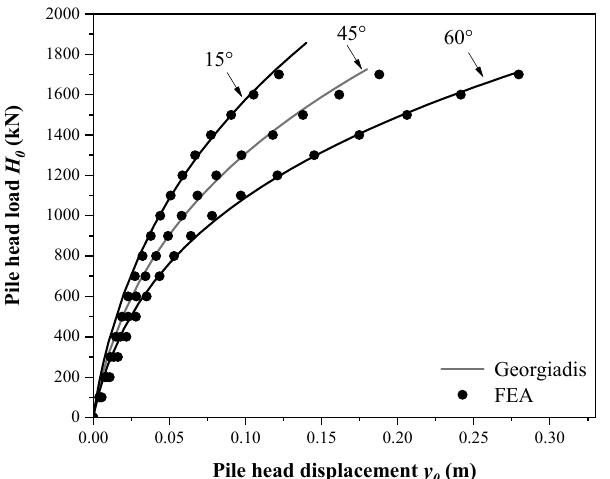
Figure 2. Comparison of FEA results with the theoretical method of the 20 m length pile and 15 ◦ , 45 ◦ ,